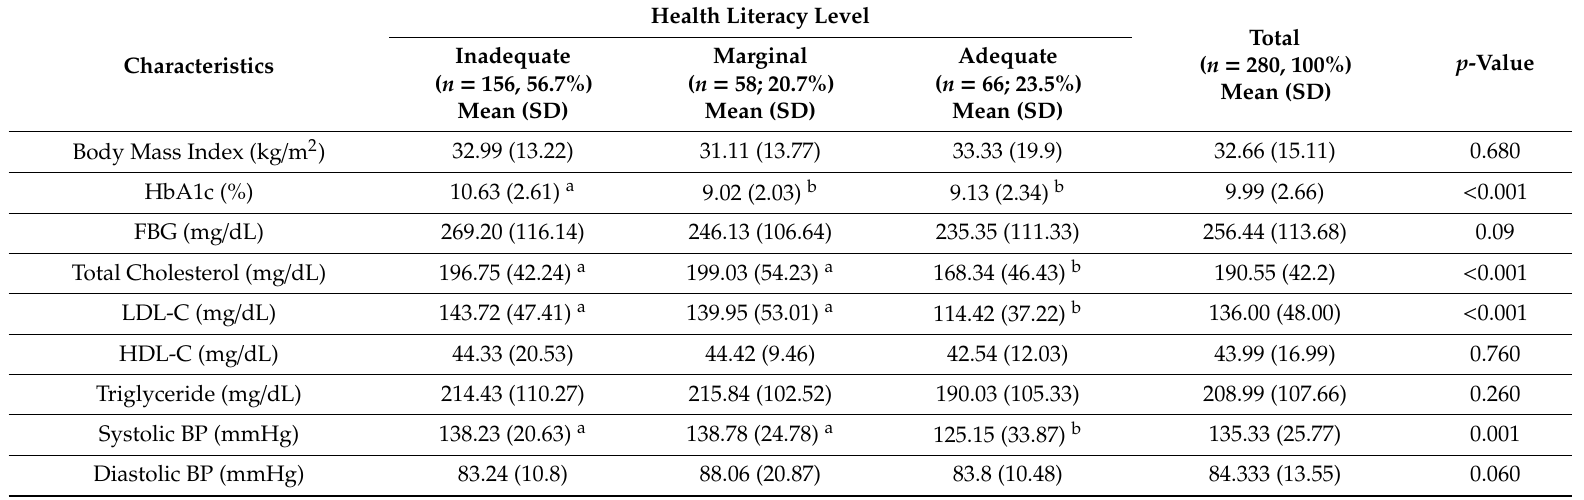
Table 2. Anthropometrics and biochemical data of respondents according to the health literacy